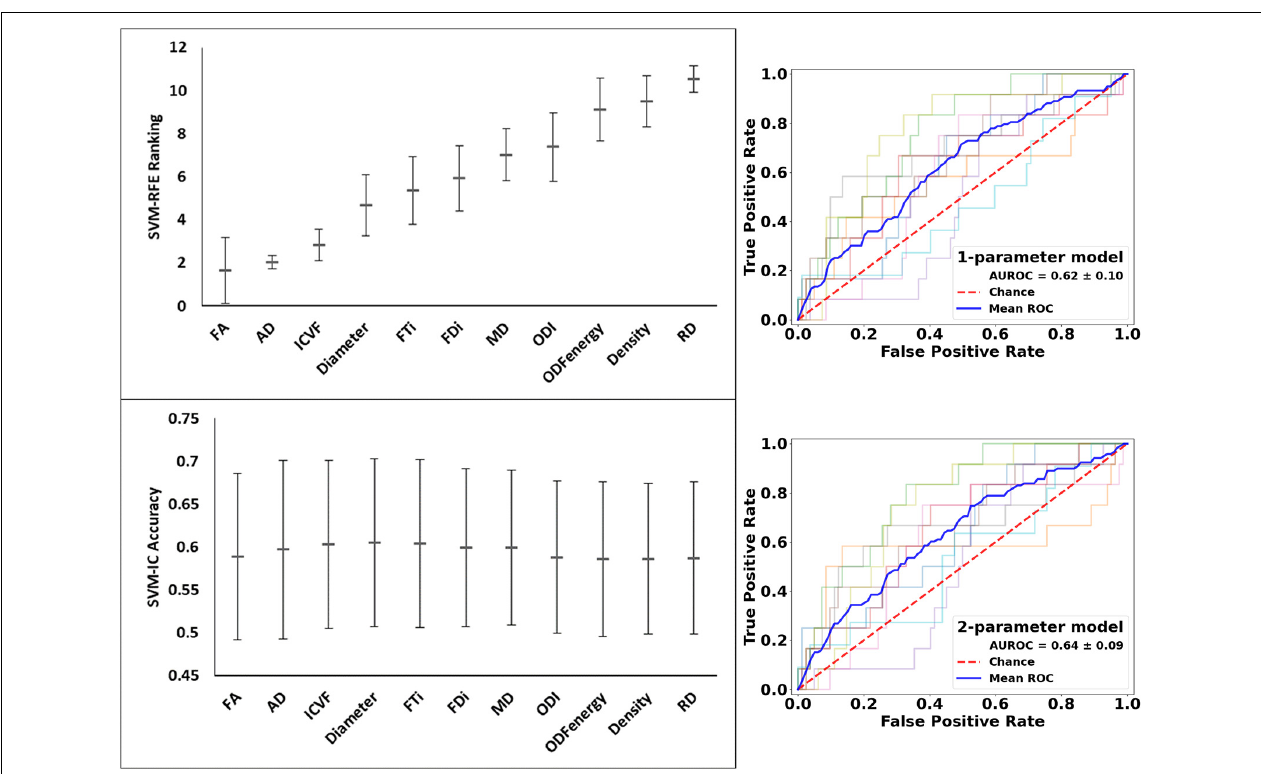
FIGURE 9 | Feature ranks and performance comparison in the classification of lesion tissue between high and low disease patients. Top Left Panel: The mean (standard deviation) rankings of the 11 diffusion features used in this analysis based on the linear recursive feature elimination (RFE) algorithm in SVM. Bottom Left Panel: Accuracy of the classification models (SVM-IC) achieved by adding features one at a time, starting from the highest to the lowest rankings. Right Panel: ROC curves for models constructed using the top two ranked diffusion features: (top fractional anisotropy (FA) alone, and bottom) FA + axial diffusivity (AD). ROC, receiver operating characteristics; AUROC, area under the ROC